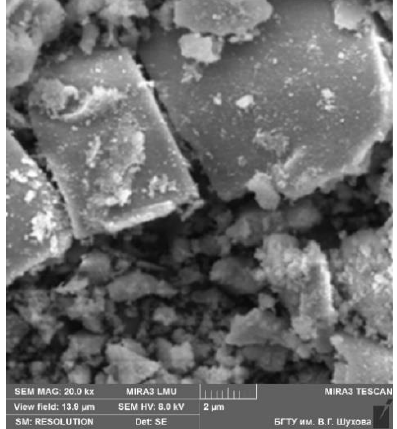
Figure 1. Microstructure of the mineral modifier.